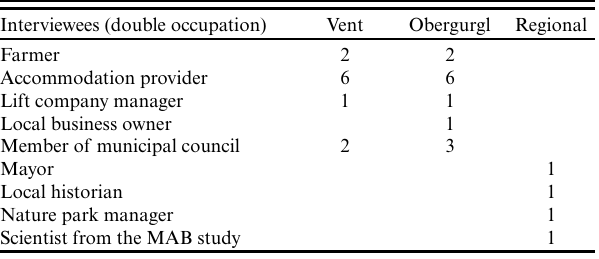
Table 1 . Stakeholders selected for expert